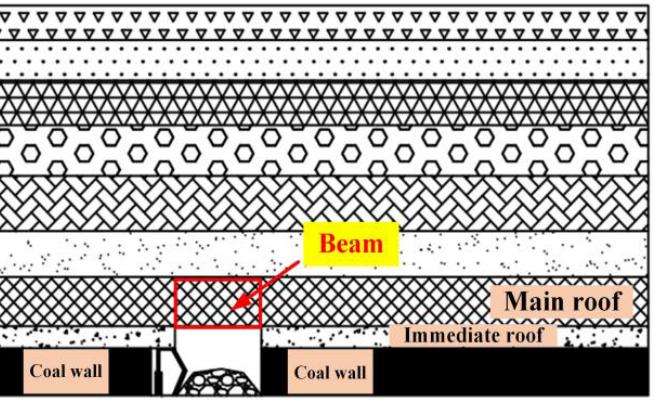
Figure 1. Initial mining.